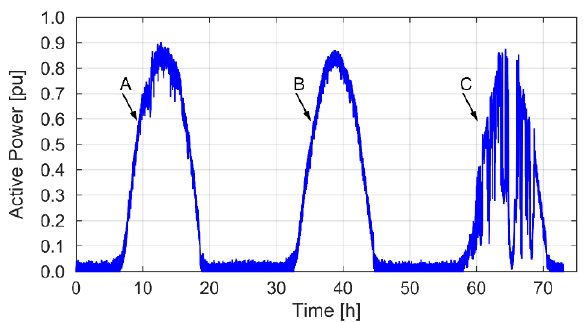
Figure 1. Example profiles of active power generation of the photovoltaic (PV) system.